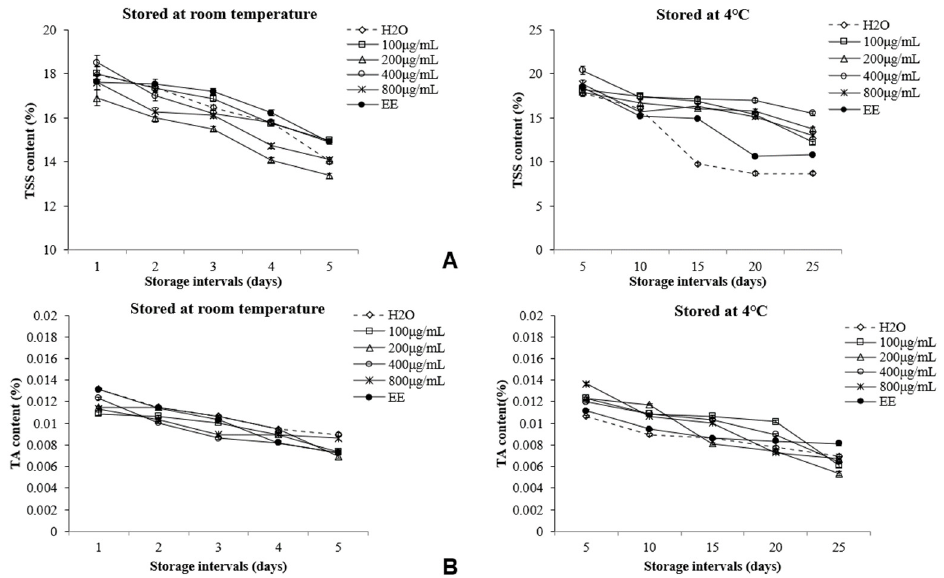
Figure 2. Effects of different treatments on total soluble solids ( A ) and titratable acidity ( B ) contents of litchi during storage.